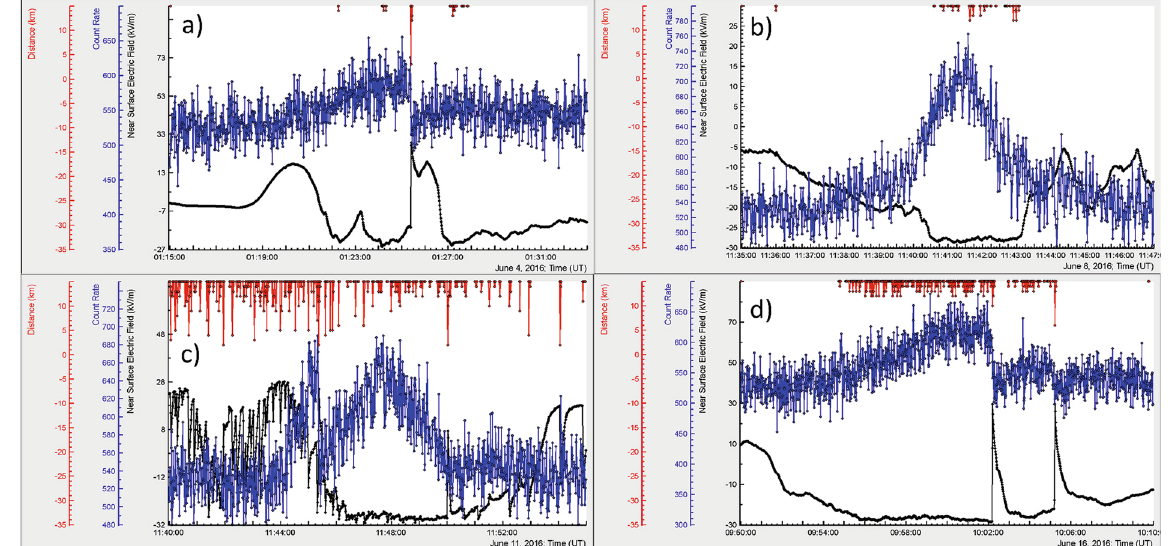
Figure 6. June TGE events abruptly terminated by nearby lightning ( a , c , d ) and – not terminated ( b ). The upper 1-cm thick plastic scintillator of STAND1 detector located nearby MAKET experimental hall measures one-second count rate. Electrostatic field and distance to lightning are measured and estimated by the EFM 100 electric mill located nearby GAMMA array.